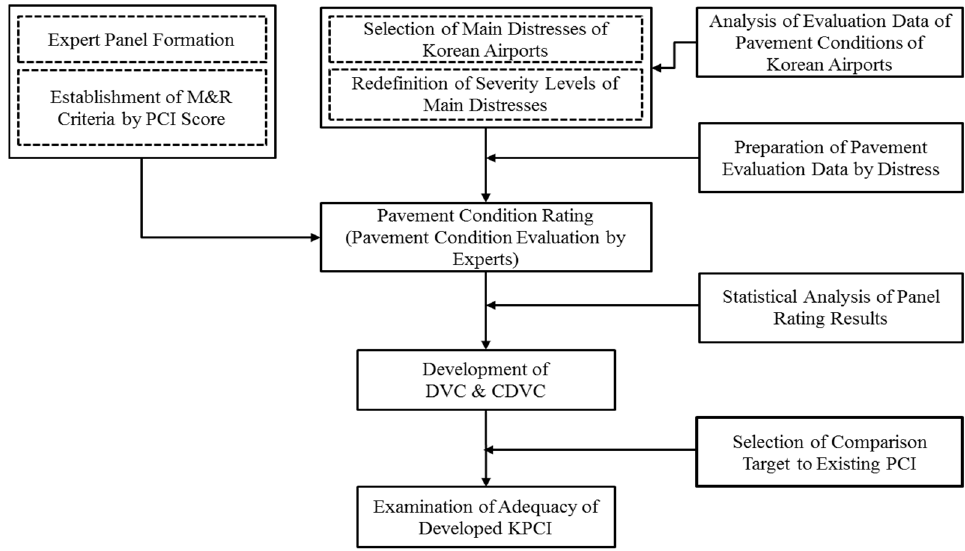
Figure 2. Development Process of KPCI.